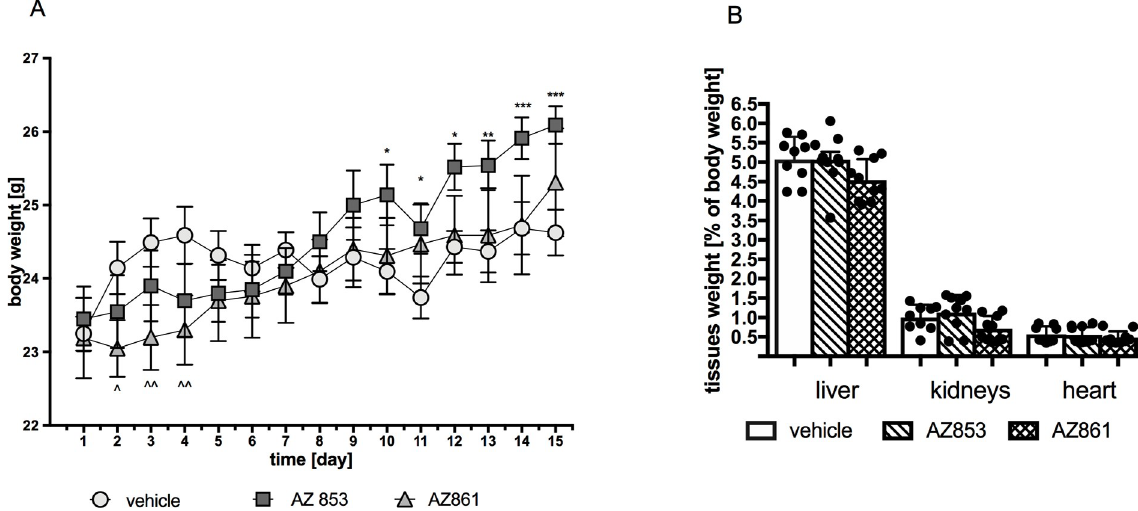
Fig 10. Effects of AZ-853 and AZ-861 on body (A) and tissues weight (B) of mice. Panel (A): data represent mean ± SEM, n = 10 per group. Statistical analysis was performed using two-way ANOVA followed by Bonferroni’s post-hoc test. Panel (B) data represent mean ± SEM, n = 9–10 per group. Statistical analysis was performed using Student’s t-test. � p < 0.05, �� p < 0.01, ��� p < 0.001 vs. control group.